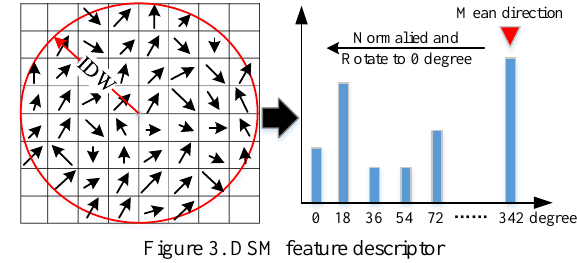
Figure 3. DSM feature descriptor